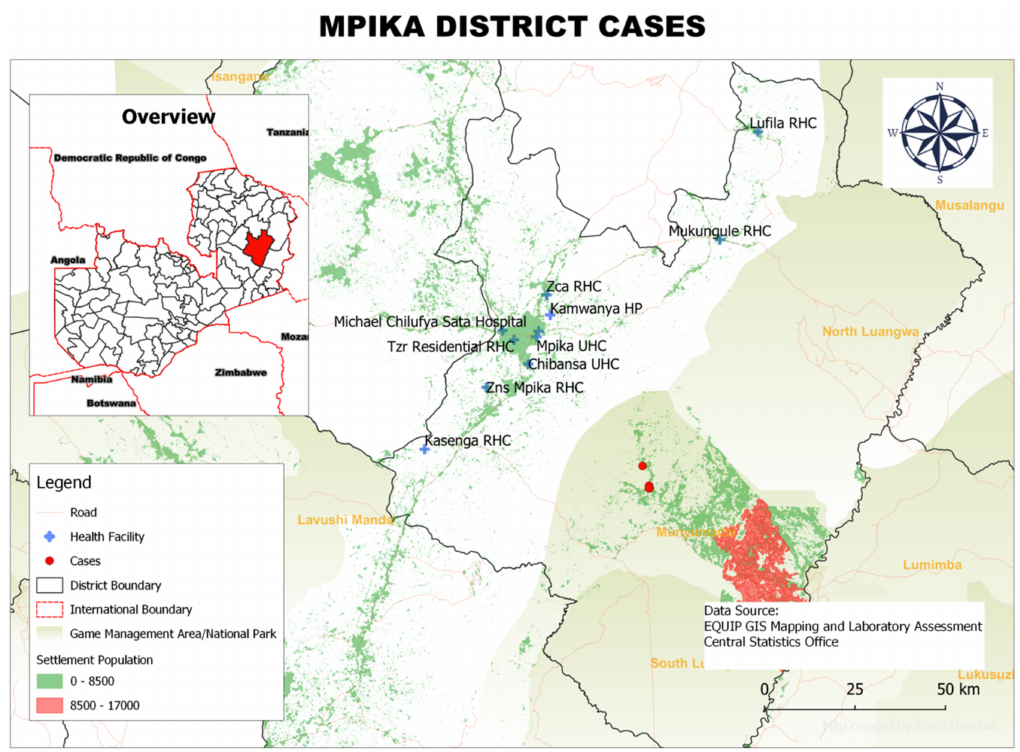
Figure 4. Spatial distribution of HAT cases from 2004 to 2014 in Mpika District, Muchinga Province,